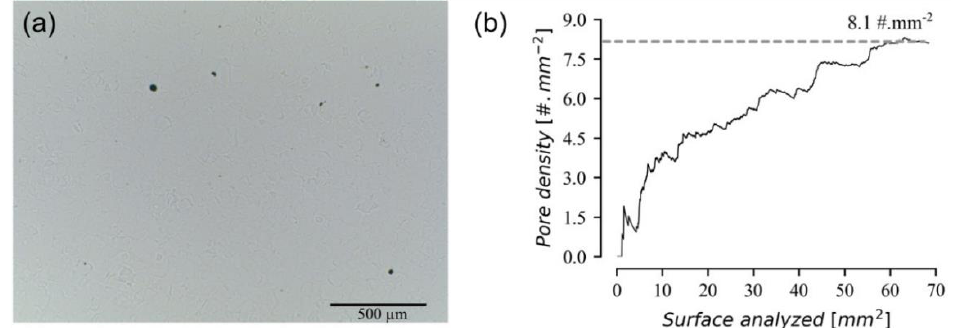
Figure 2. Pore density measurements ( a ) surface optical image ( b ) corresponding pore density vs. analyzed surface (# is the number of pores observed).